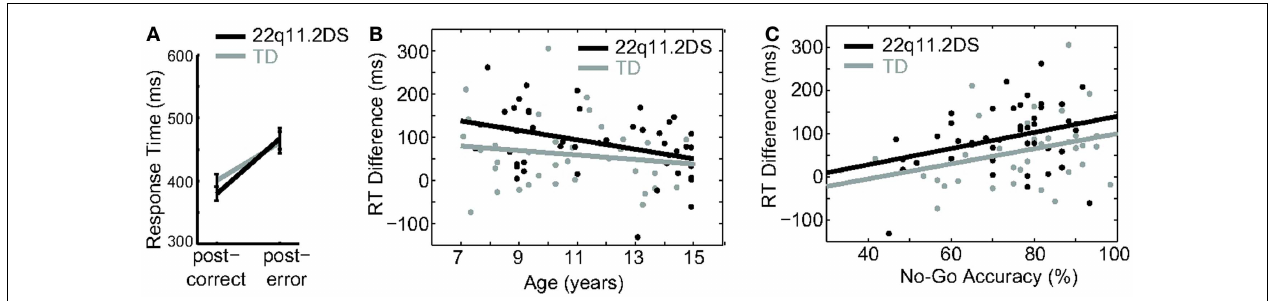
FIGURE 5 | Conflict monitoring . (A) Both groups demonstrated significant post-error slowing. (B) Post-error slowing was negatively associated with age in both groups. (C) Post-error slowing corresponded with better reactive inhibition in both